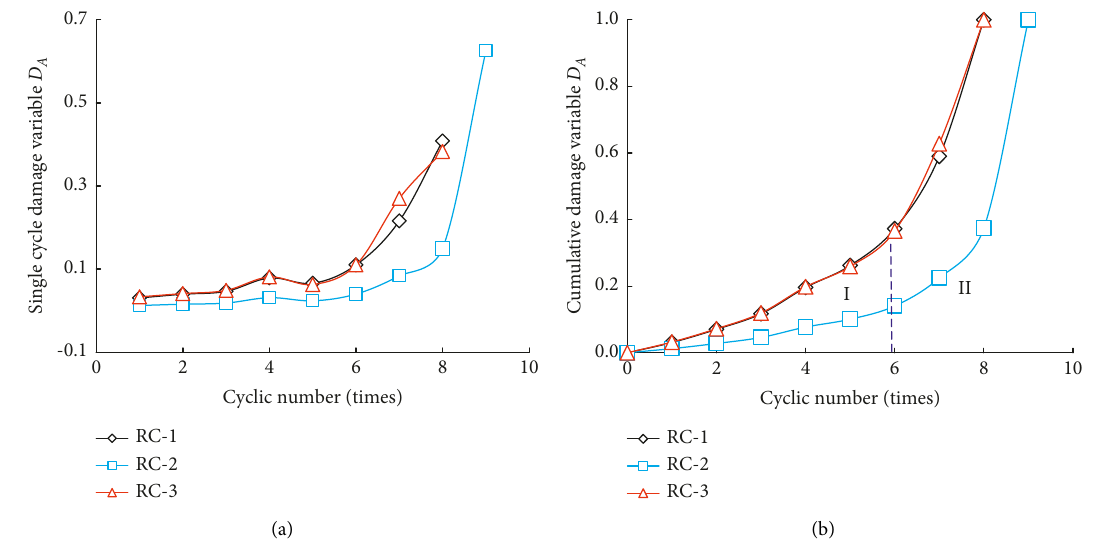
Figure 8: Damage variable curve based on AE characteristics. (a) D